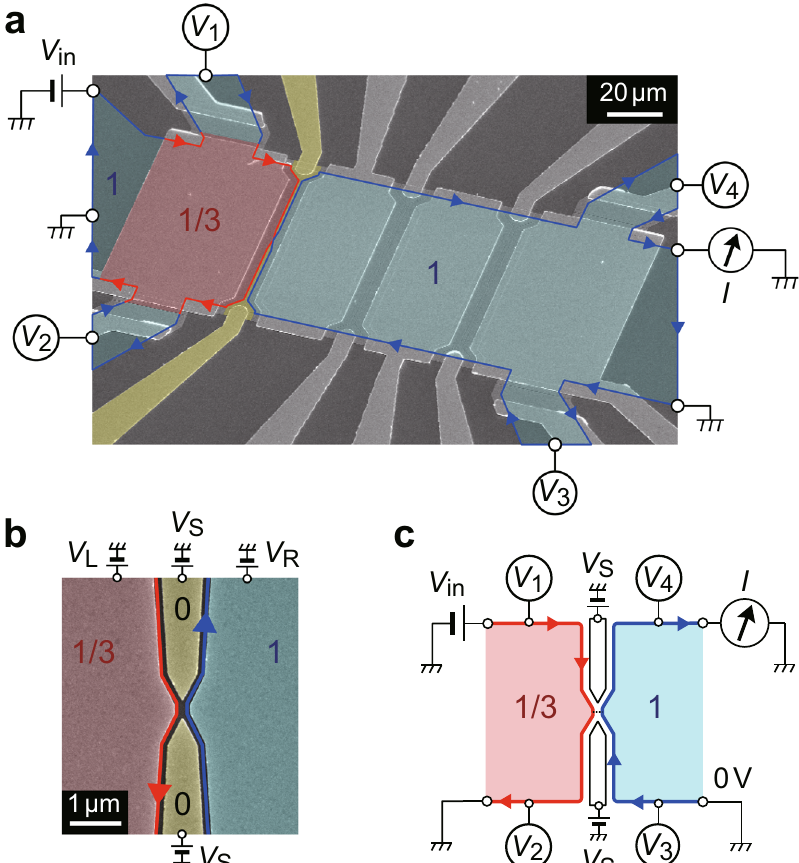
Fig. 1 Fractional-integer quantum Hall junction. a , b False-colour scanning electron micrograph of the Hall-bar sample with measurement con fi gurations ( a ) and magni fi ed view near the narrow junction ( b ). A perpendicular magnetic fi eld B = 9 T is applied from the back to the front of the sample. The v = 1 states develop over the wide blue regions in the 2DES with the front-gate voltages, including V R , set at 0 V. Meanwhile, electron density below one of the front gates (red region) is reduced to form the v = 1/3 state by applying V L = − 0.42 V. A narrow 1/3-1 junction is formed by depleting the 2DES under the split gate electrodes (yellow) with negative V S . Chiral edge states are displayed by arrows (blue, between v = 1 and v = 0; red, between v = 1/3 and v = 0). V I is the measured current, and V i ( i = 1 – 4) are the measured voltages of the incoming and outgoing channels of the in is the applied source-drain voltage, 1/3-1 junction. c Schematic of the experimental setup. A narrow junction is formed between v = 1/3 and v = 1